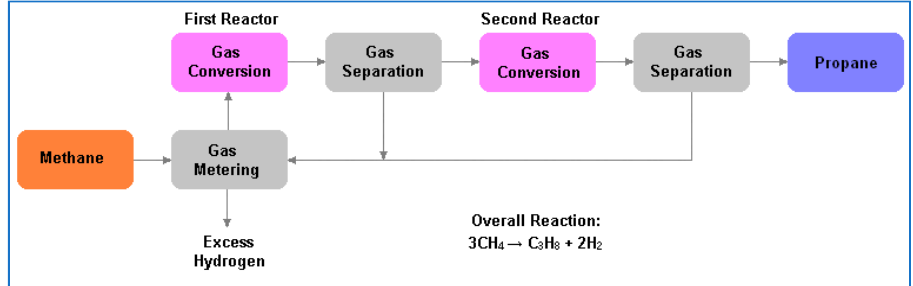
Figure 4. Alkcon’s process for methane to propane.